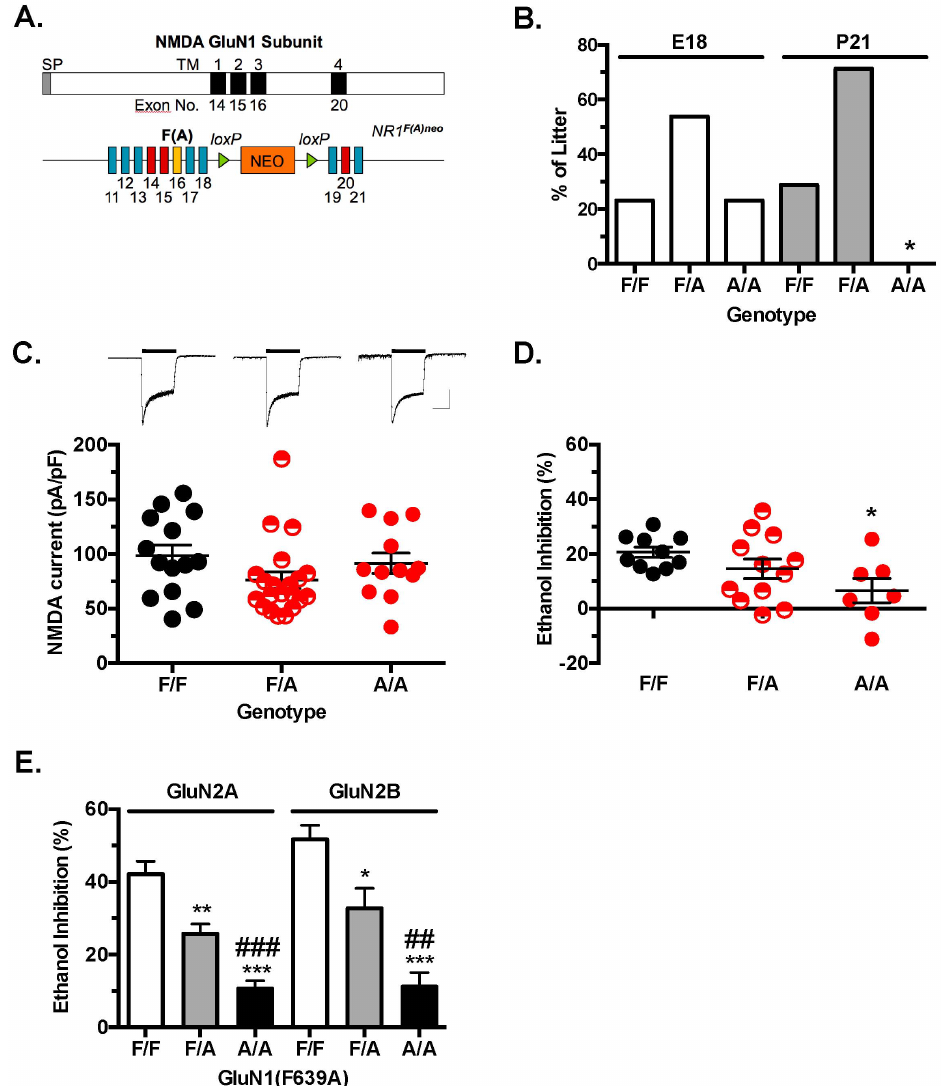
Figure 1. Targeted point mutation (F639A) in the GluN1 subunit decreases ethanol sensitivity of NMDA receptors. ( A ), Top: Schematic of GluN1 protein with transmembrane domains ( solid bars ) and corresponding exons. Bottom: Gene construct used to generate the F639A mice. F(A) is site of mutation within exon 16. NEO cassette flanked by loxp sites is between exons 18 and 19. ( B ), Percent of wild-type (F/F), heterozygous (F/A), and homozygous (A/A) F639A mice alive at embryonic day 18 or post-natal day 21. Symbol: ( * ) no surviving mice. ( C ), Top panel: Sample traces from 14-day old primary hippocampal cultures during ( black bar ) application of 50 m M NMDA/10 m M glycine. Scale bars: y-axis, 2000 pA; x-axis, 2.5 ms. Bottom panel: Mean amplitude of NMDA evoked currents in cultures from wild-type (F/F, n=14), heterozygous (F/A, n=21) and homozygous (A/A, n=12) F639A mice. ( D ), Ethanol inhibition from 14-day old primary hippocampal cultures. Percent inhibition of steady state current by 100 mM ethanol from wild-type (F/F, n=10), heterozygous (F/A, n=12) and homozygous (A/A, n=7) F639A mice. Symbol ( * ): value significantly different from wild-type ( * p , 0.05; one-way ANOVA, Dunnett’s post hoc test). ( E ), Ethanol inhibition of recombinant wild-type and mutant NMDA receptors expressed in HEK293 cells. Data represent percent inhibition by 100 mM ethanol in cells expressing GluN1 or GluN1(F639A) with either GluN2A (F/F, n=5; F/A, n=14; A/A, n=10) or GluN2B subunits (F/F, n=6; F/A, n=8; A/A, n=9). Symbols: ( * ) significantly different from wild-type ( * p , 0.05, ** p , 0.01, *** p , 0.001; one-way ANOVA, Bonferroni’s post hoc test); ( # ) significantly different from F639A Het ( ## p , 0.01, ### p , 0.001; one-way ANOVA, Bonferroni’s post hoc test). doi:10.1371/journal.pone.0080541.g001 performed on brain tissue isolated from adult wild-type and genotypes ( t (13) =0.06, ns; Figure 2E). Although the amplitudes mutant mice. As shown in Figure 3, there were no changes in the and total charge transfer in response to NMDA were similar expression of the GluN1 or GluN2B subunits between wild-type between groups (Figure 2F), currents in neurons from heterozy- and F639A Het mice in dorsal striatum, hippocampus, amygdala gous mice rose more quickly during bath-applied NMDA than and nucleus accumbens. Levels of GluN2A were also similar those from wild-type mice (mixed ANOVA: main effect of time, between wild-type mice and F639A Het mice in all regions except F (53,689) = 24.63, p , 0.001; and a significant interaction, for the mPFC where there was a slight reduction ( , 20%) noted for F (53,689) = 3.831, p , 0.001; Figure 2E). To examine expression of F639A Het mice ( t (8) =3.2, p , 0.05; Figure 3C). NMDAR subunits in adult animals, western blotting was